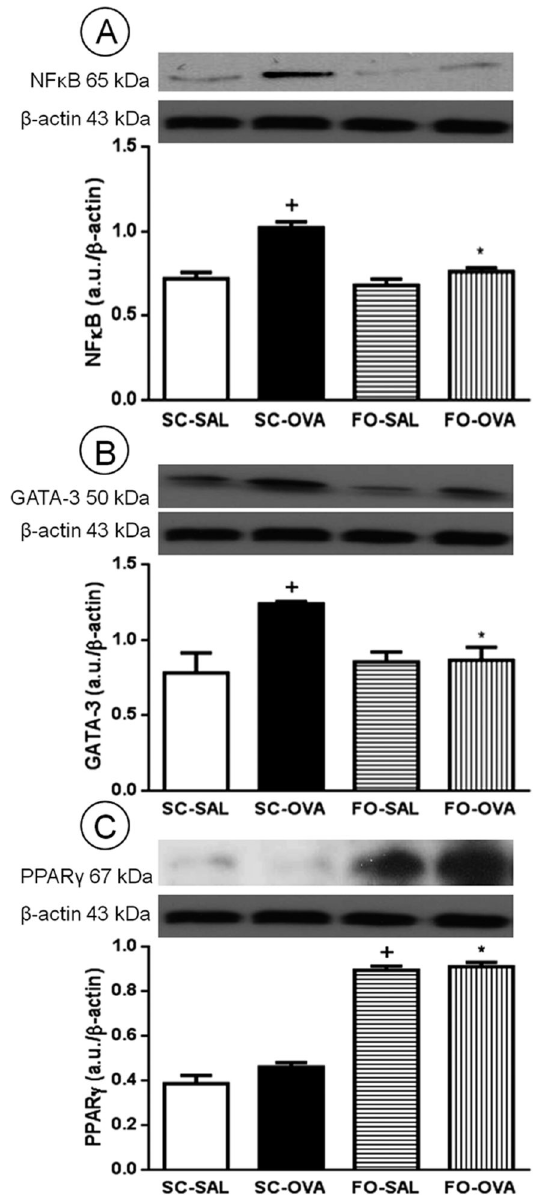
Figure 8. Effect of FO intake on nuclear factor kappa B (NFκB) (A), GATA-3 (B) and peroxisome proliferator- activated receptor gamma (PPARγ) (C) expression in A/J mouse pulmonary tissue. Sensitized, saline-challenged (SC- SAL); sensitized, ovalbumin-challenged (SC-OVA); sensitized, saline-challenged with fish oil (FO-SAL) and sensitized, ovalbumin-challenged with fish oil (FO-OVA). The results were standardized to β-actin expression and were expressed in arbitrary units (a.u.). The analyses were performed 24 hours after the last challenge. In the signaled cases, P <0.05 compared with the SC-SAL group (+) and the SC-OVA group (*) (one-way ANOVA and post-hoc Holm-Sidak test). Values are the means ± S.E.M. and are representative of 1 experiment (n=5 per group). doi: 10.1371/journal.pone.0075059.g008 PLOS ONE |